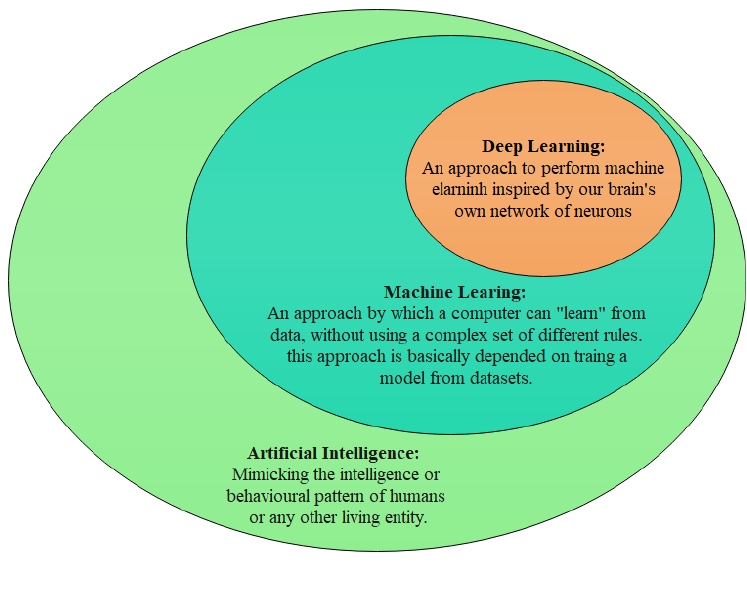
Figure 9. Relation between Artificial Intelligence, Machine Learning and Deep Learning.